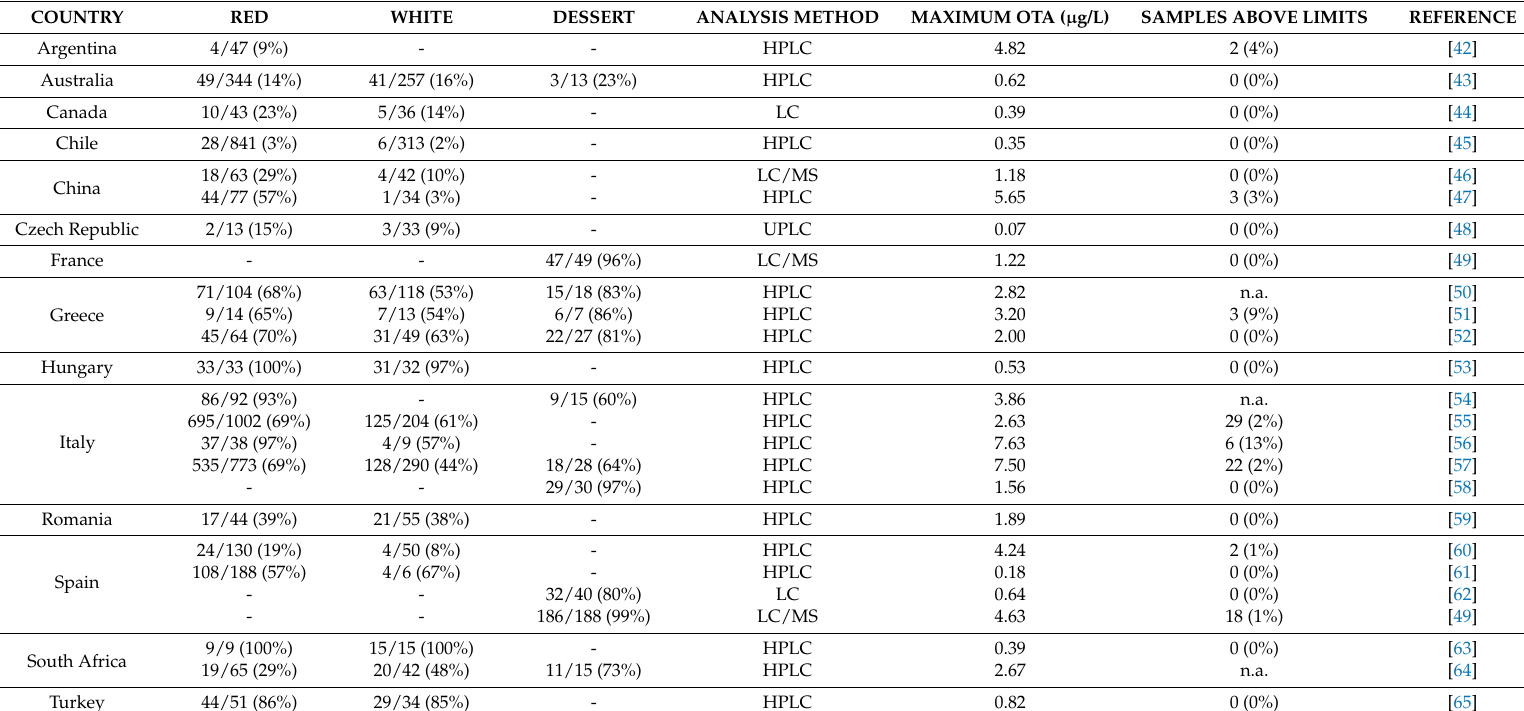
Table 1. Main studies regarding the worldwide occurrence of OTA in red, white and dessert wines. The results are indicated as the number of positive samples/total samples (percentage of positive samples) of each type of wine. The number of samples exceeding the EU legal limits (2 µ g/L) as well as the percentage represented by these samples (between parentheses) are also indicated. The analysis methods used and the highest concentration detected are